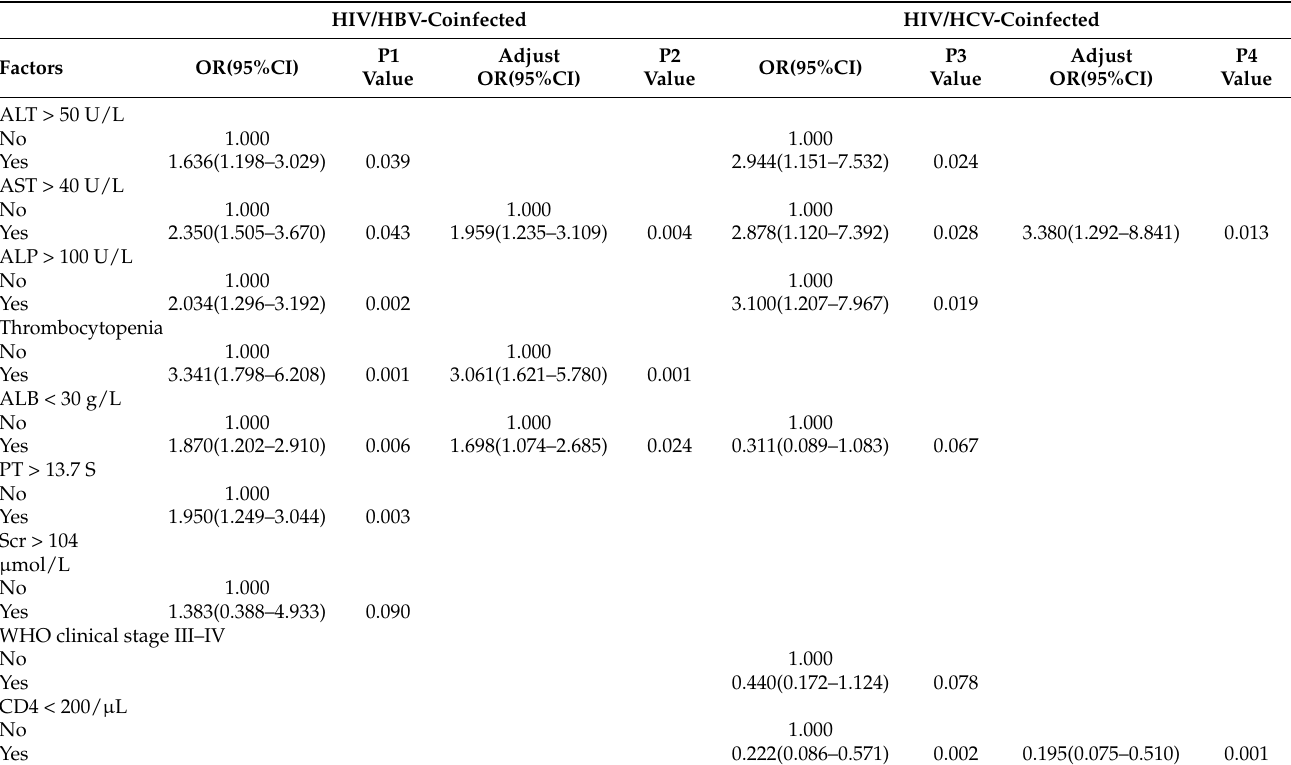
Table 3. Factors associated with HBV or HCV coinfection in HIV-positive